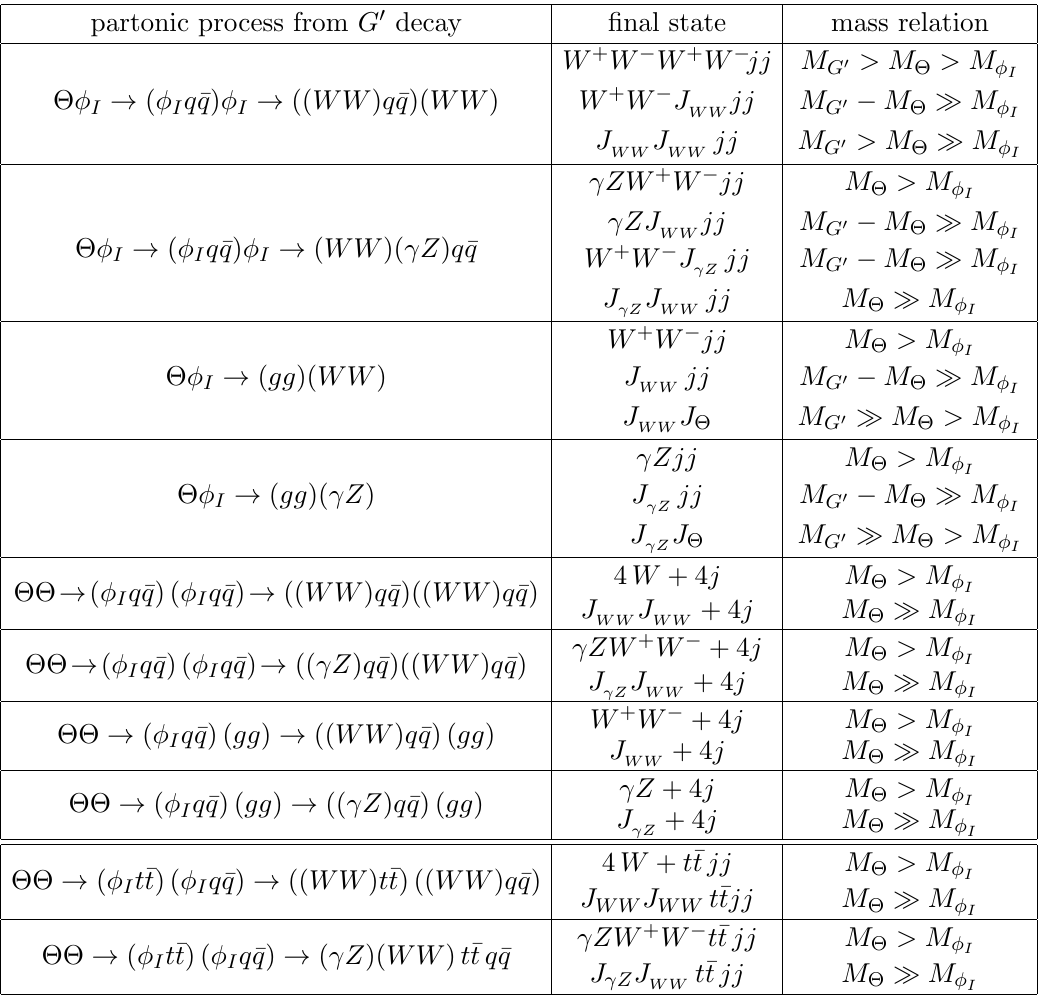
Table 2 . LHC processes predicted in the ReCoM when M (cid:30) I < M (cid:2) and (cid:30) I ! WW or (cid:13)Z . J WW and J (cid:13)Z represent a W + W (cid:0) or (cid:13)Z system produced in the decay of a boosted (cid:30) I . These originate . 1 TeV, and may appear as E . 100 GeV. Additional from a displaced vertex for M (cid:30) T = for M (cid:30) I I channels (e.g., those involving two t (cid:22) t pairs or (cid:30) I ZZ ) have smaller branching fractions. The ! mass relations displayed here are necessary but not su(cid:14)cient (e.g., (cid:13)ZJ jj also requires that M (cid:2) WW is not much larger than M (cid:30) I